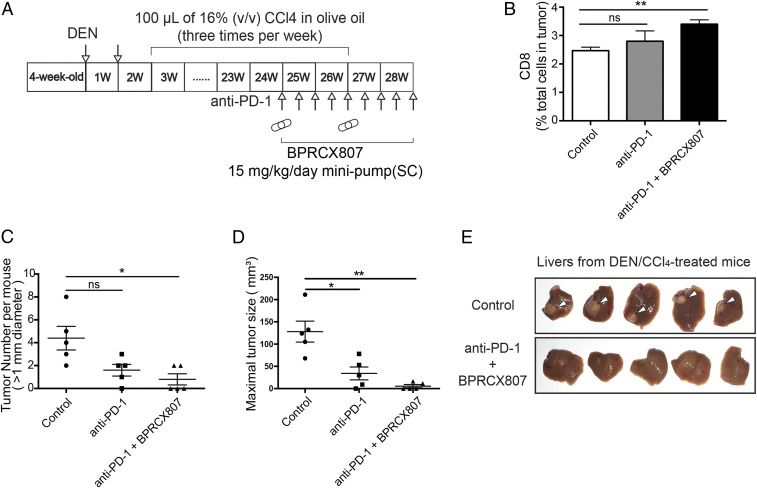
Anticancer effects of BPRCX807 with immune therapy in DEN/CCl4-induced liver fibrosis associated HCC model. (A) Experimental protocol. (B) Analysis of CD8+ T cells (n = 3 mice). (C) Liver tumor nodule counts (>1 mm) per mouse (n = 5 mice). (D) Measurement of tumor size (n = 5 mice). (E) Representative livers in a DEN/CCl4-induced spontaneous HCC model; white arrows pinpoint tumor sites in fibrotic liver. The data are the mean value ± SEM. *P < 0.05 and **P < 0.01. ns, not significant.